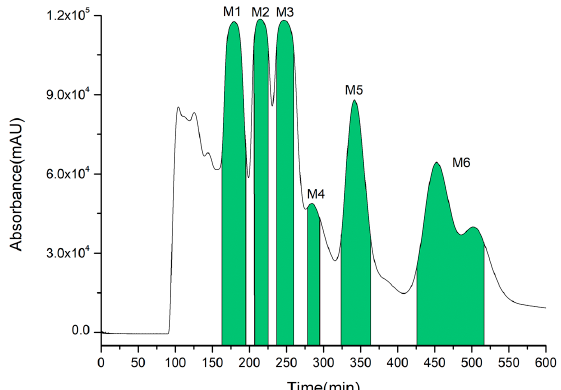
Figure 6. HSCCC chromatogram of OHPLE. Solvent system: n -butanol–MTBE–ethanol–0.1% acetic acid (3:1:1:6, v / v ). The detection wavelength was 340 nm. Sample loading was 250 mg in 20 mL of